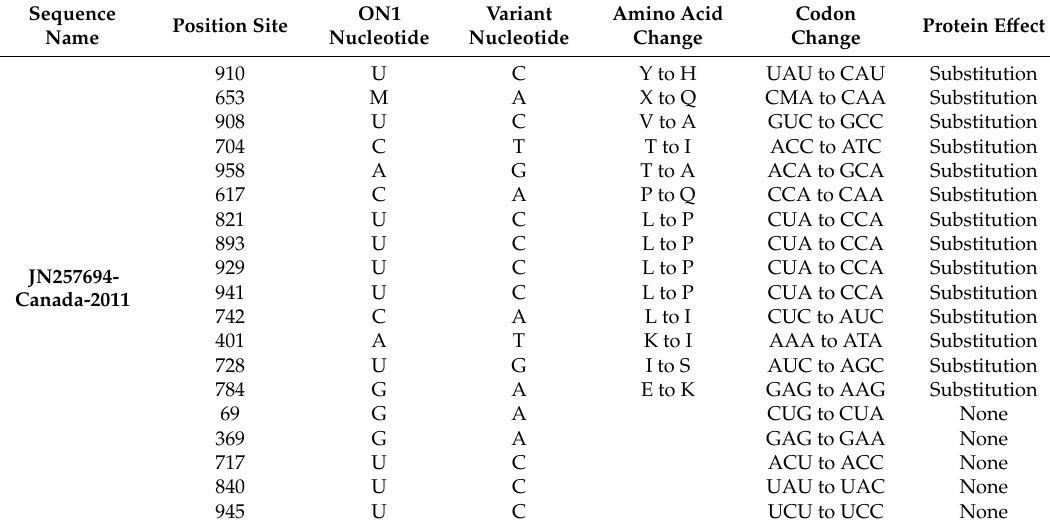
Table 2. The nucleotide variation between the RSV-A Jeddah strains and the ON1